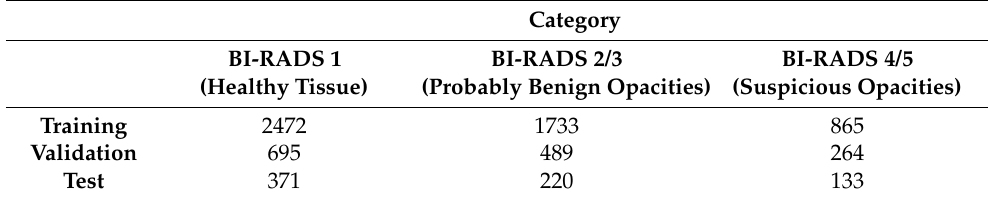
Table 1. Number crops of mammograms used for training, validation and testing of the different dCNN models.